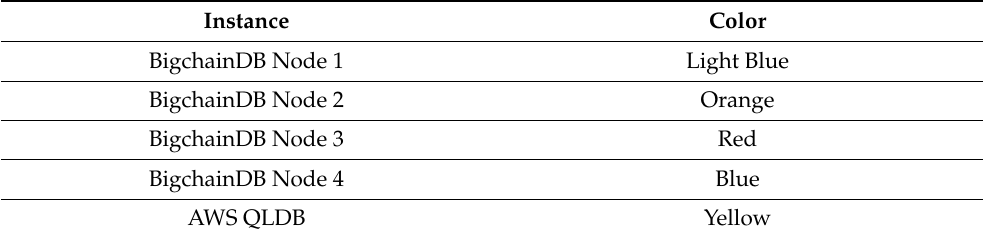
Table 9. Color mapping. Instance